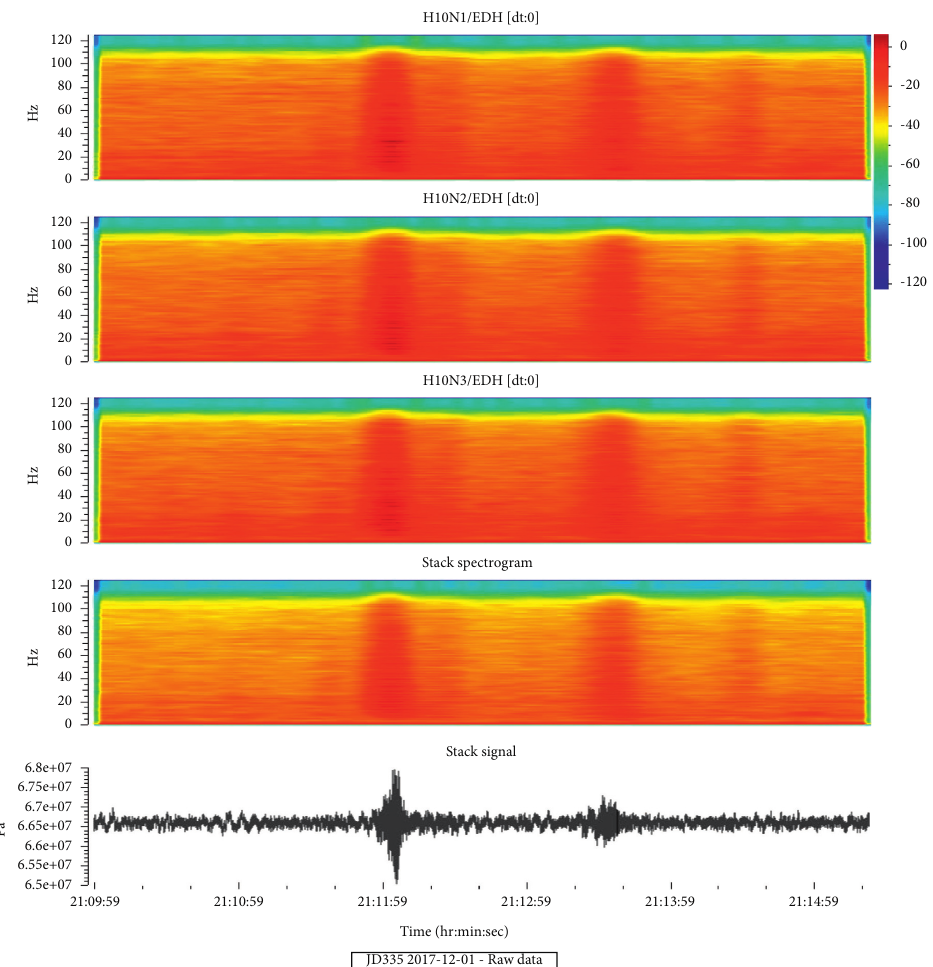
Figure 7: The raw data and spectrum of December 1, 2017, recorded by the H10N station.